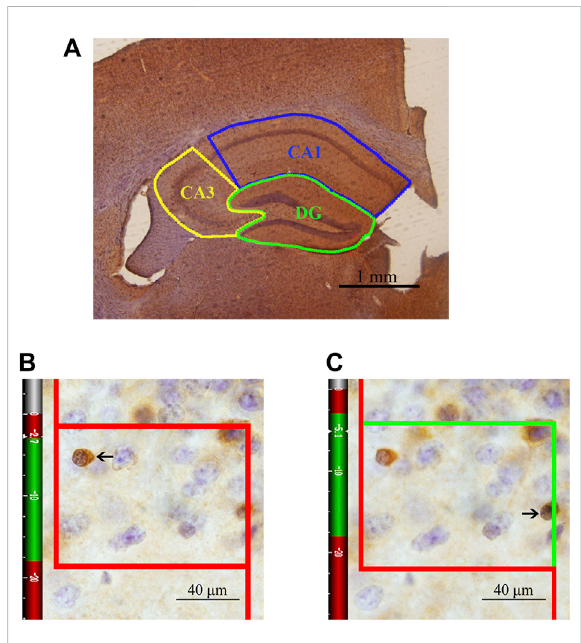
FIGURE 2 Schematic diagram of the subregions of the hippocampus and an illustration of the optical fractionator technique for counting of CC1 + cells. (A) The area indicated by the solid blue line representstheCA1area,theareaindicatedbythesolidyellow line represents the CA3 area, and the area indicated by the solid green line represents the DG. Bar = 1 mm. (B) The CC1 + cells that are clearly in focus in the guard zone were not counted. (C) The CC1 + cells that are clearly in focus in the counting zone, as indicated by the arrows, were counted. Bar = 40 μ